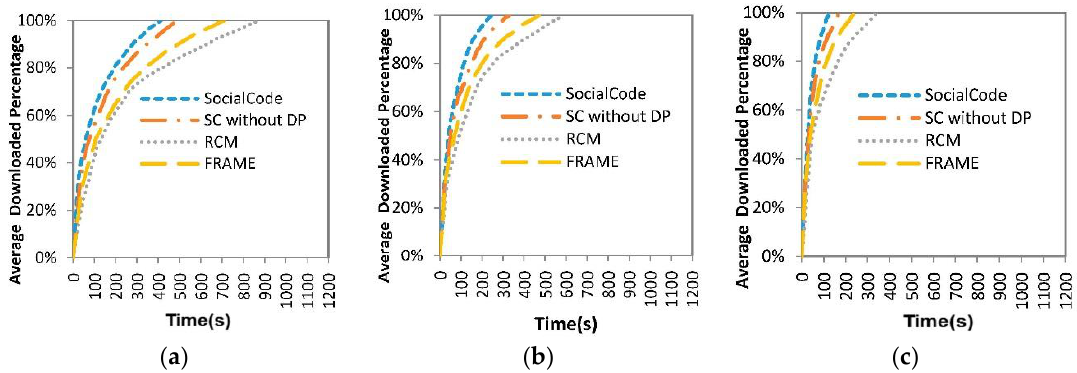
Figure 9. Average downloading percentage vs. file size ( a ) 10 MB; ( b ) 6 MB; ( c ) 2 MB.